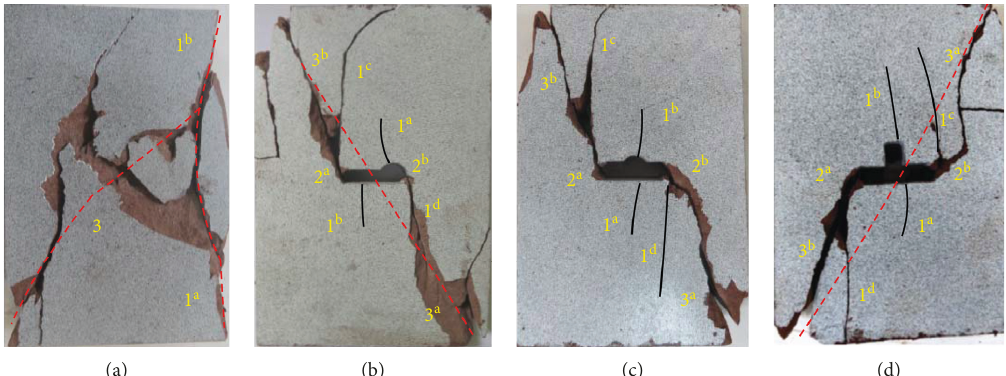
Figure 10: Failure modes of four types of specimens subjected to axial loads: (a) specimen IS-3; (b) specimen TI-1; (c) specimen FI-1; (d) specimen SI-3.